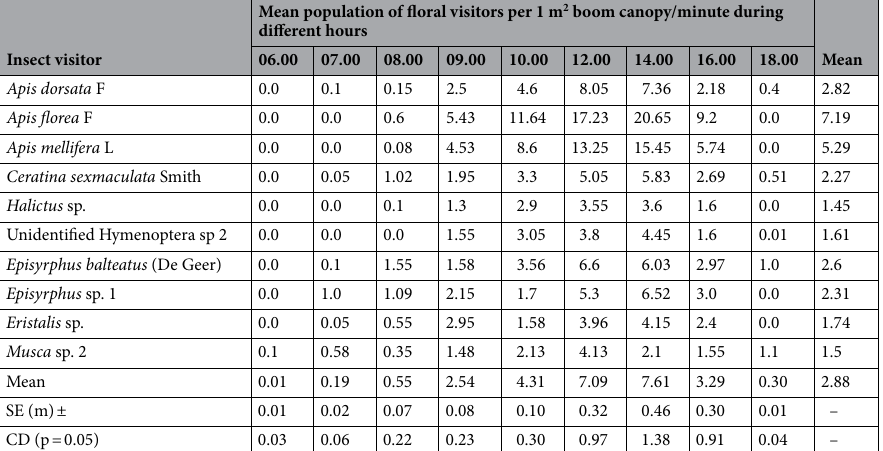
Table 3. Temporal abundance of important floral visitors on dill crop in semi-arid region during winter cropping season. The data given in table are the pooled data of 2 years research (2016–17 & 2017–18). *√x + 1 transformed value of tabulated data were used for statistical analysis.